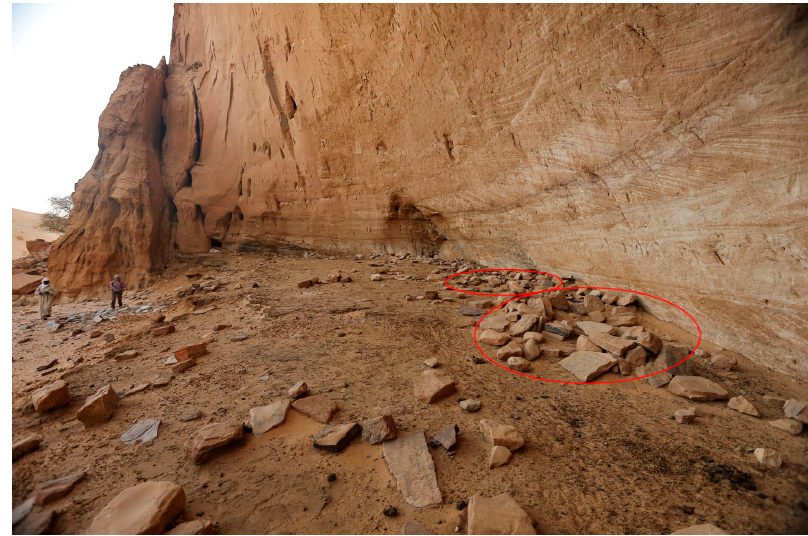
Figure 3. View from west of the Nabara 2 shelter (Photo: Alessandro Menardi Noguera). Small stone circles lie against the bottom wall (red ellipses).